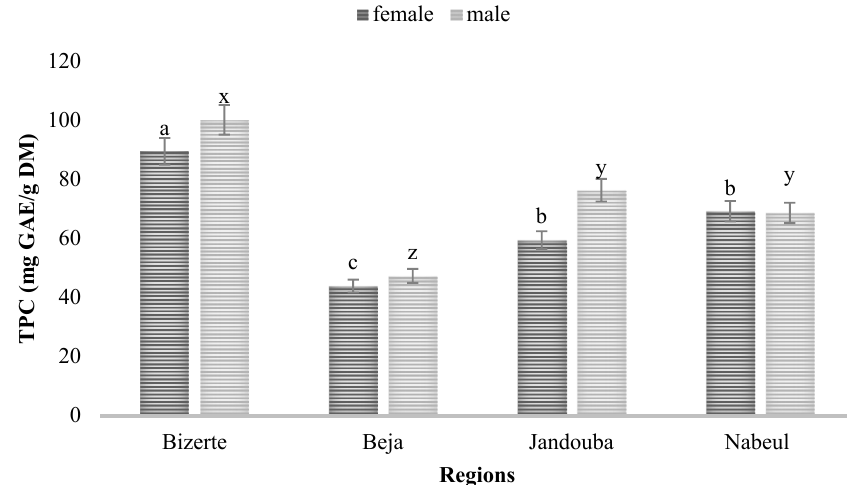
Figure 1. Total phenolic contents (TPC) of leaves of male and female plants of M . annua from Bizerte, Beja, Jandouba and Nabeul provenances. Results of the Bonferroni test are significantly different at p < 0.05. Marked columns not linked by the same letter are significantly different at p < 0.05, and each data point is represented by the average of three repetitions ± SD.